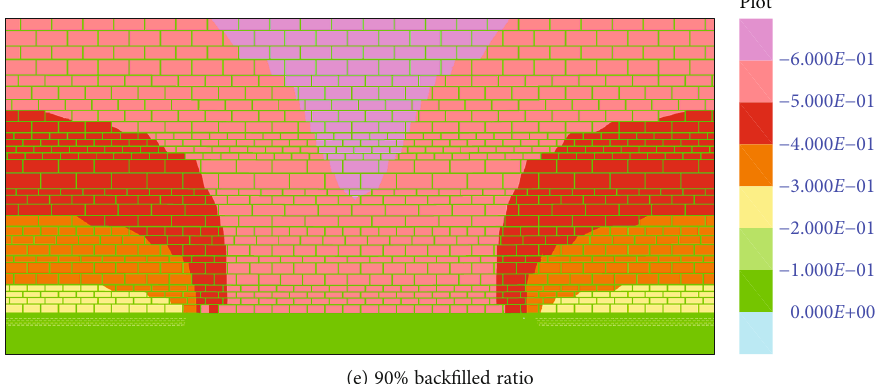
Figure 6: Migration characteristics and displacement contours of the overburden structure under di ff erent mining